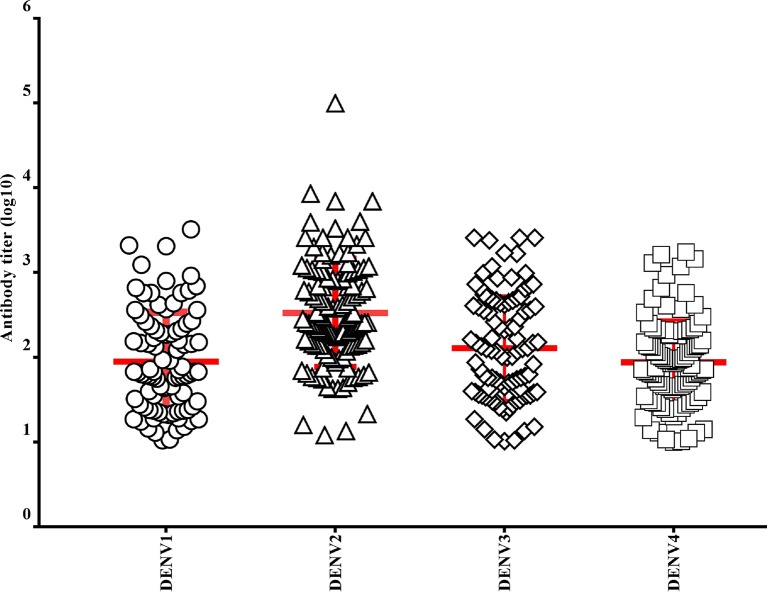
PRNT90 antibody titers (log10) in different dengue serotypes (Red line indicates mean titers with standard deviation).